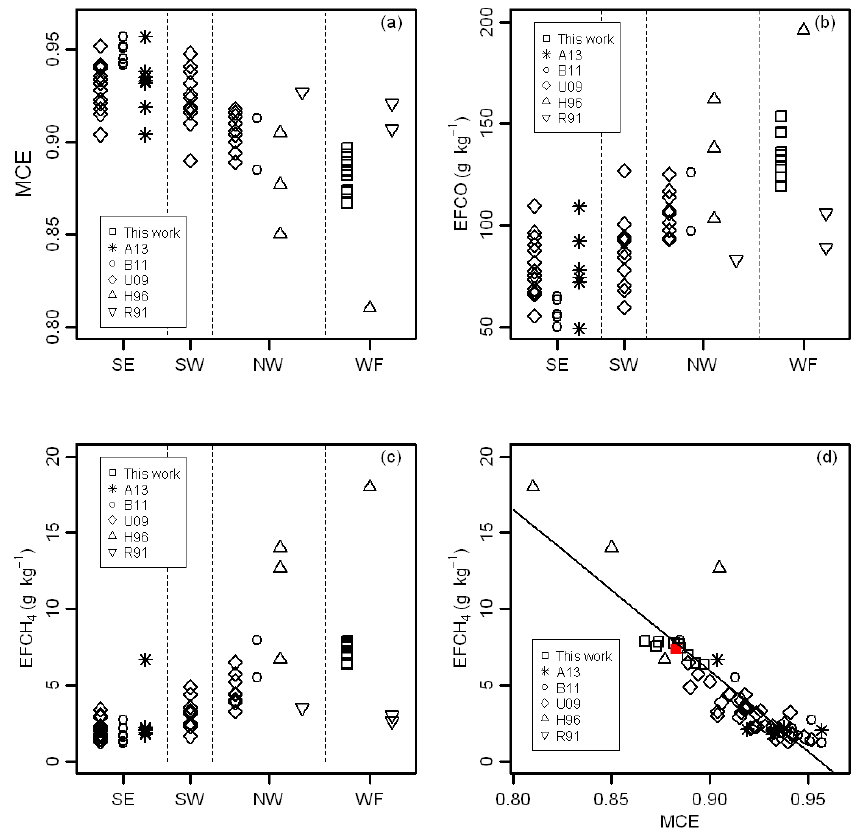
Fig. 4. (a) MCE, (b) EFCO, and (c) EFCH 4 for this work and from several other studies plotted by region for prescribed fires (SE=southeast, SW=southwest, NW=northwest). WF=wildfires. (d) EFCH4 vs. MCE for this work and several other studies. The filled red square is the average for our study (Table 2). The solid line is the linear regression best fit to data from previous studies only (A13, B11, U09, H96, and R91). Best fit line is y = − 106.10 ×+ 101.4, r 2 = 0 .